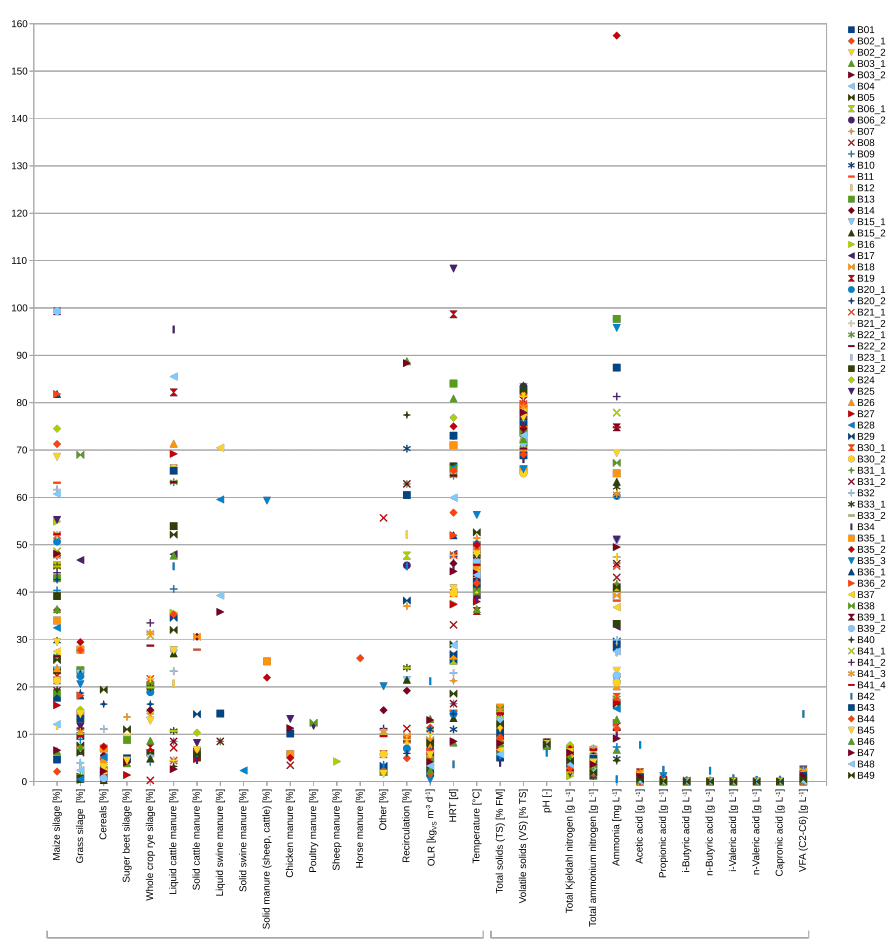
Figure 1. Range of the operational and chemical process parameters from the 67 analyzed anaerobic digesters. The different units of the paramaters are indicated on the x -axis. Supplied feedstocks were normalized to 100% for each digester. The acid concentrations were summarized as volatile fatty acids (VFA) given as acetic acid equivalents. OLR = organic loading rate, HRT = hydraulic retention